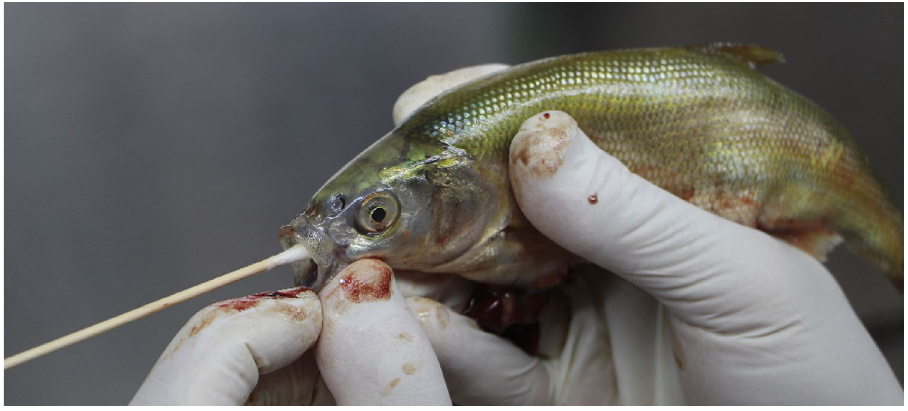
Figure 3. Sampling by a swab from a pearl mullet